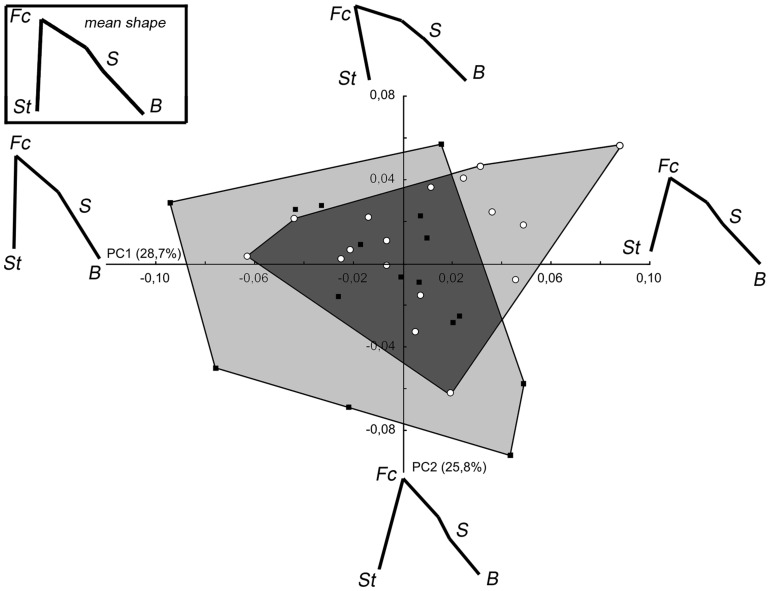
PCA_Pan: Set1 (facial block orientation) in Pan.For legend see figure 4.